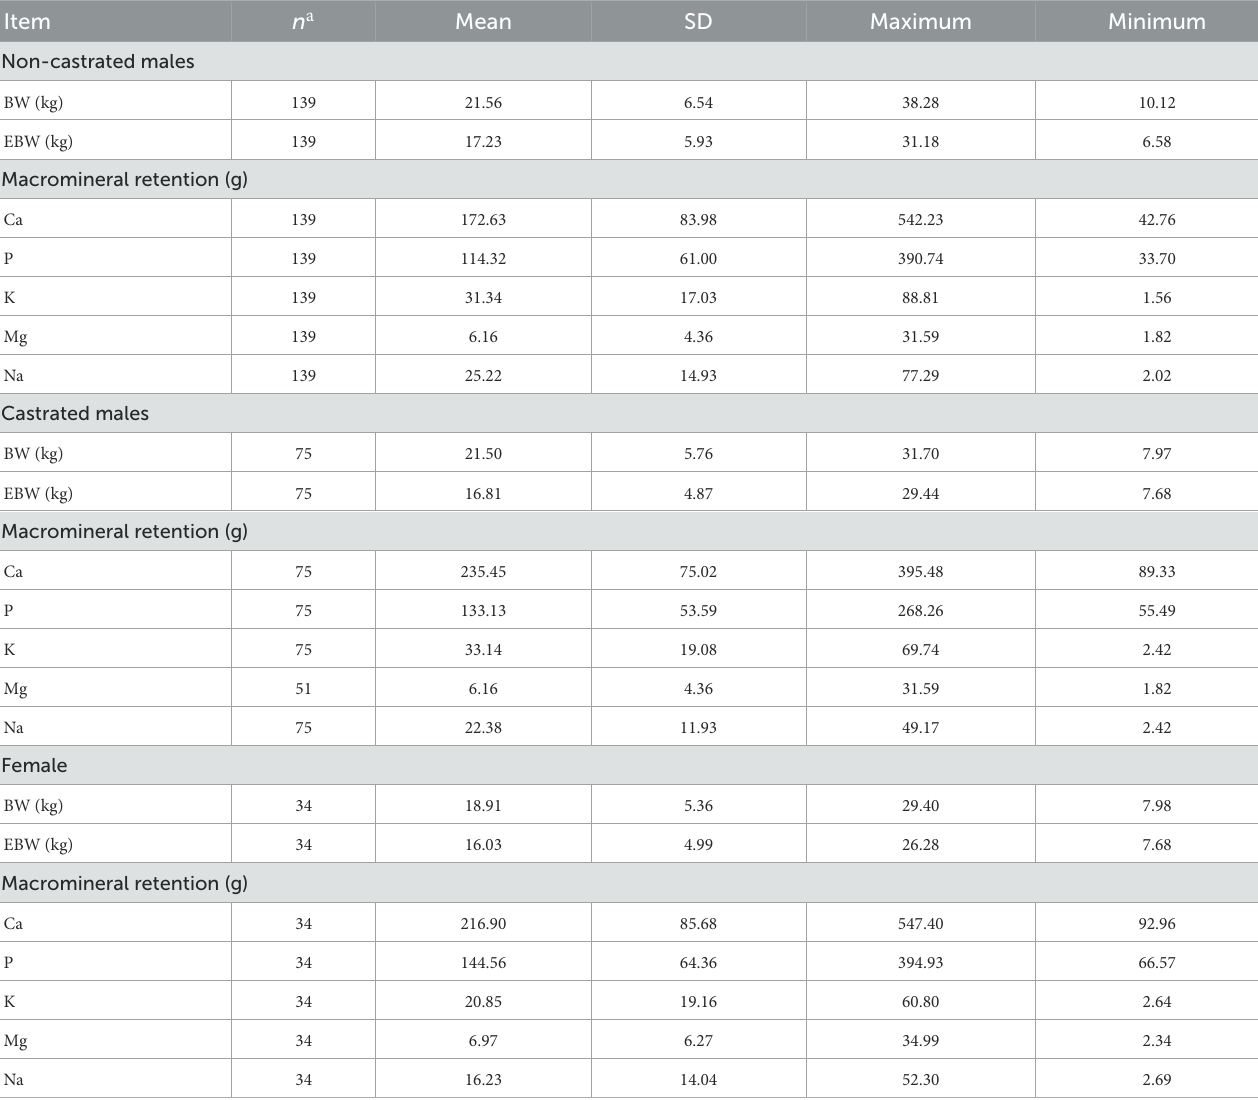
TABLE 2 Descriptive statistics of the data used to estimate the net requirements of macrominerals for gain in hair sheep.